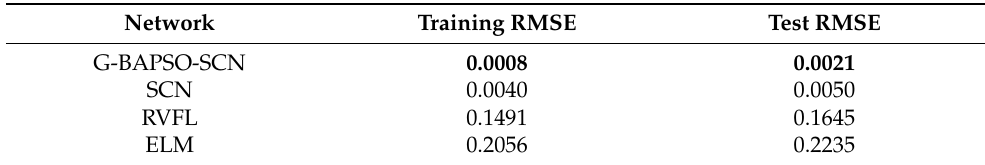
Figure 10. The average convergence curve (Dataset 4). Table 8. Performance comparison results (Dataset 1).